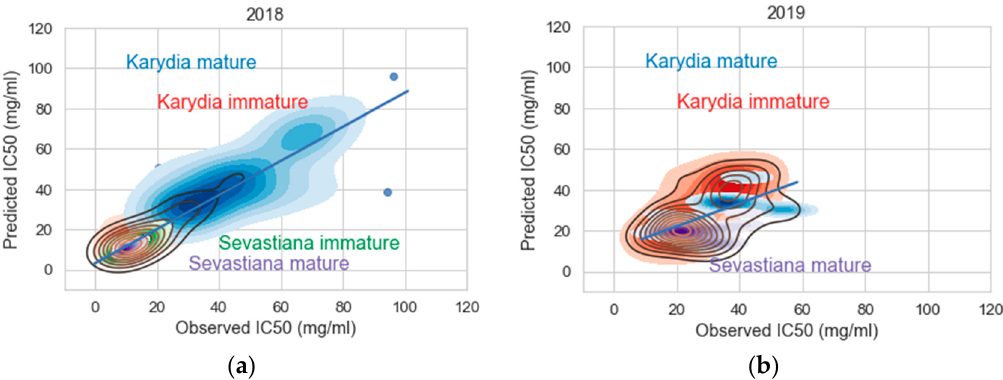
Figure 12. Kernel density plots showing the relationship between observed and predicted IC50 values in the DPPH assay using the XGBoost model for ( a ) 2018 and ( b ) 2019.